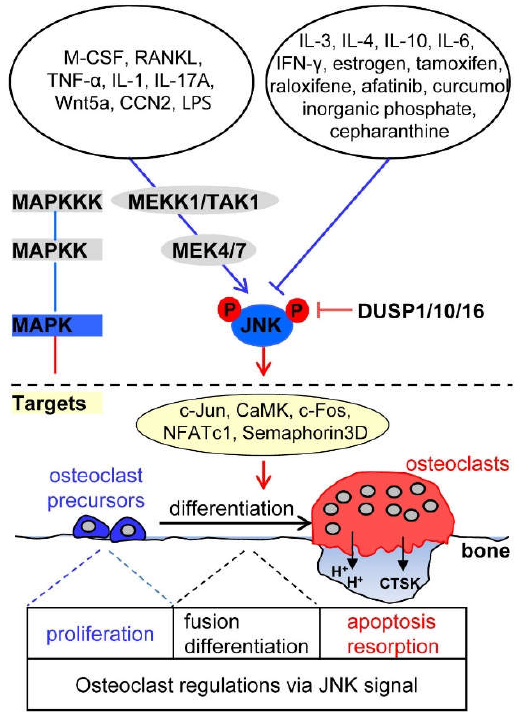
Figure 2. Osteoclastogenic signaling cascade controlled by upstream activators and inhibitors of c-Jun N-terminal kinase (JNK). The indicated molecules are described in the section of “JNK signaling in osteoclasts”. Arrows indicate activation of the signaling pathways while T bars indicate inhibition of the signaling pathways.